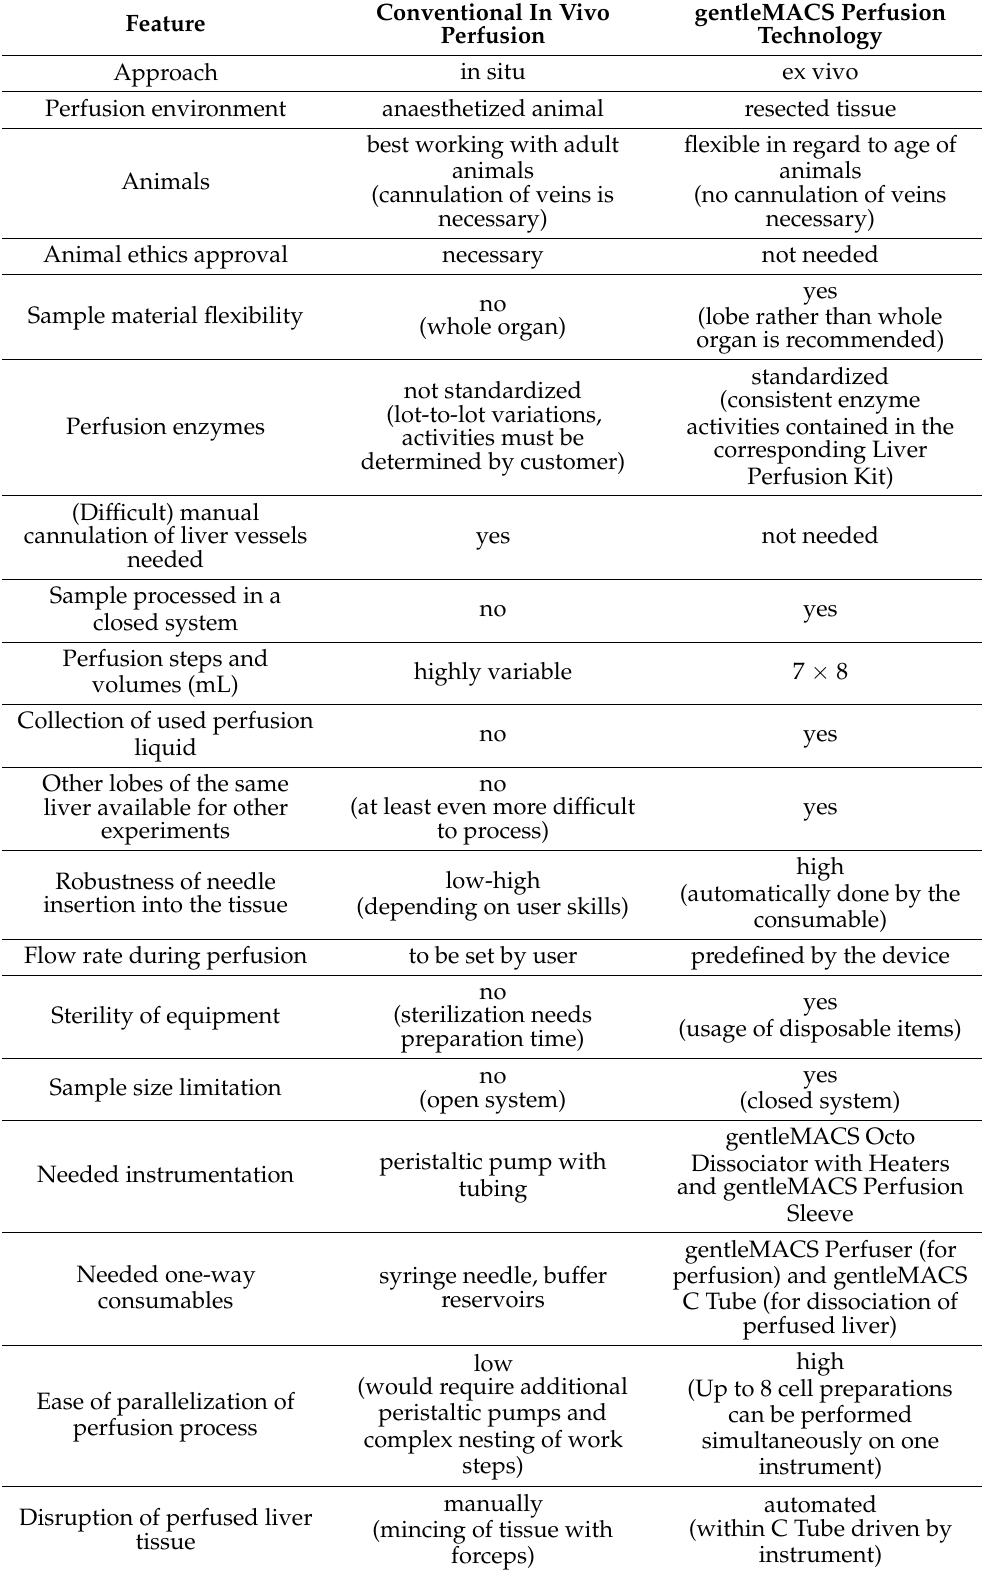
Table 2. Differences between the standard perfusion and the gentleMACS Perfusion